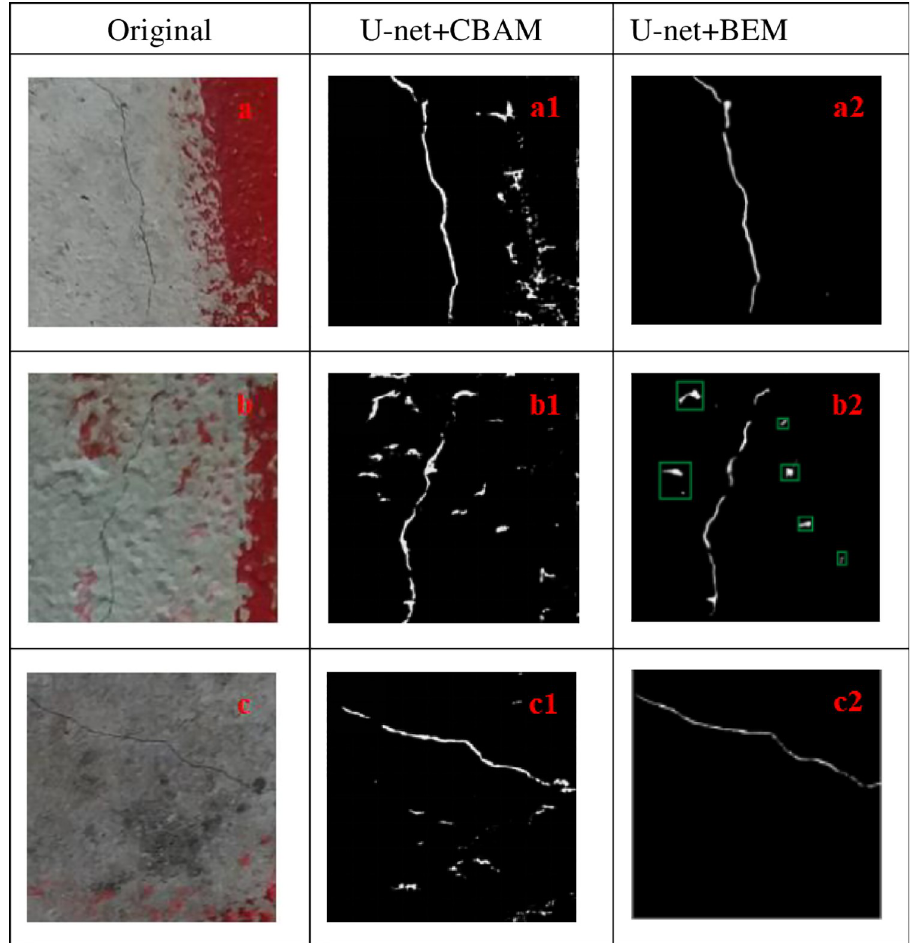
Fig 10. Attention mechanism comparison